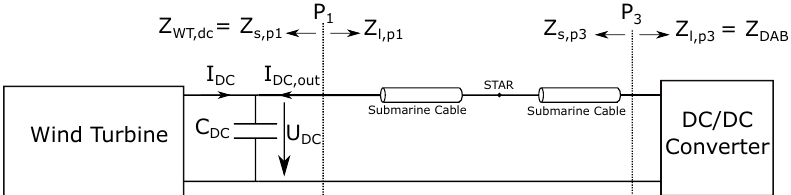
Figure 5. Single wind turbine interconnected